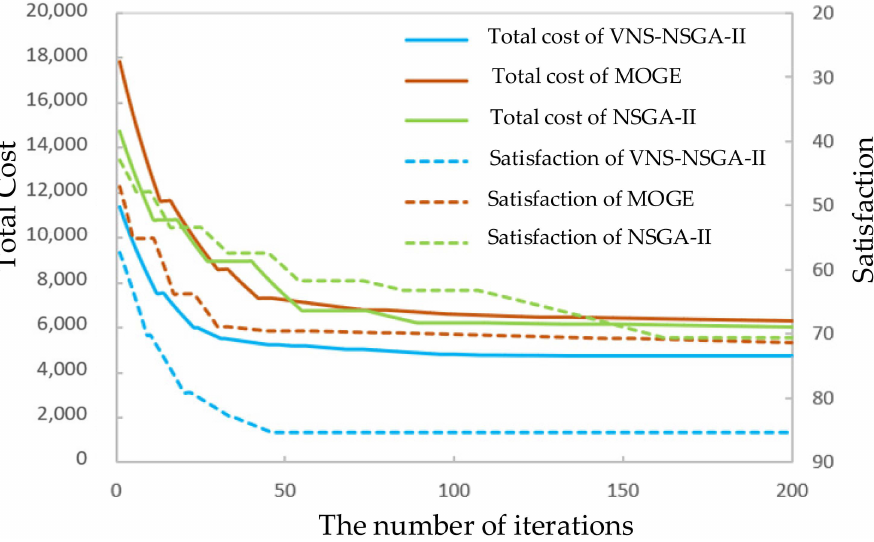
Figure 7. Comparison of convergence of algorithms. Table 3. Experimental results of algorithm